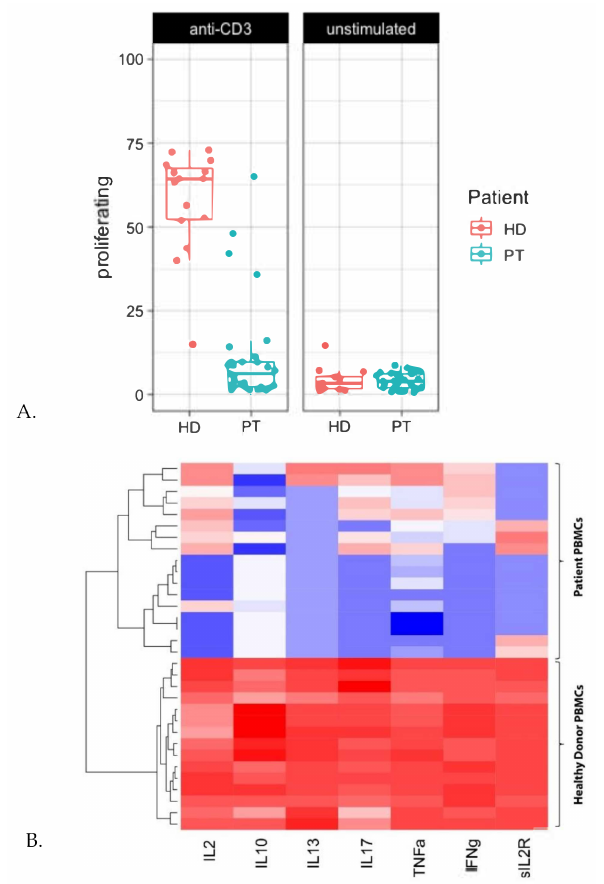
Figure 8. T-cell proliferation is impaired at diagnosis as well as during therapy in HR-NBL. ( A ) PBMCs of healthy donors (HD) (red) and patients (PT) (blue) were stimulated with anti-CD3 (0.5 µ g/mL). T-cell proliferation of each individual sample is shown (duplos were pooled); PBMCs HD ( n = 8), PBMCs patients ( n = 12). ( B ) Supernatants (HD n = 15, patients n = 17) were analyzed using Luminex-based multiplex immunoassays. The heatmap shows the log concentration of IL-2, IL-10, IL-13, IL-7, TNF- α , IFN- γ and soluble IL-2R, with low levels indicated in blue and high levels indicated in